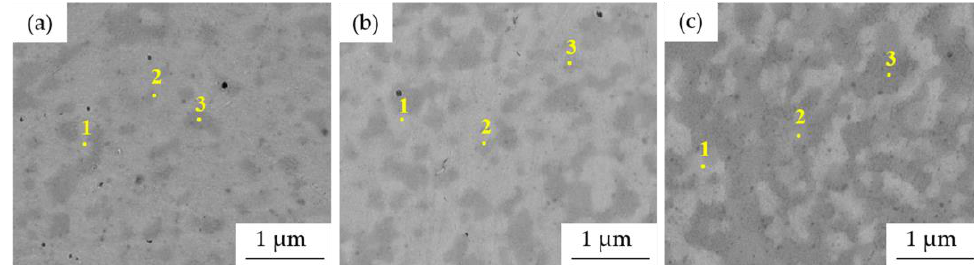
Figure 11. Thermal stability of the MA + SPS alloys as a hardness change during annealing at 800 °C. (Error bars represent confidence intervals).